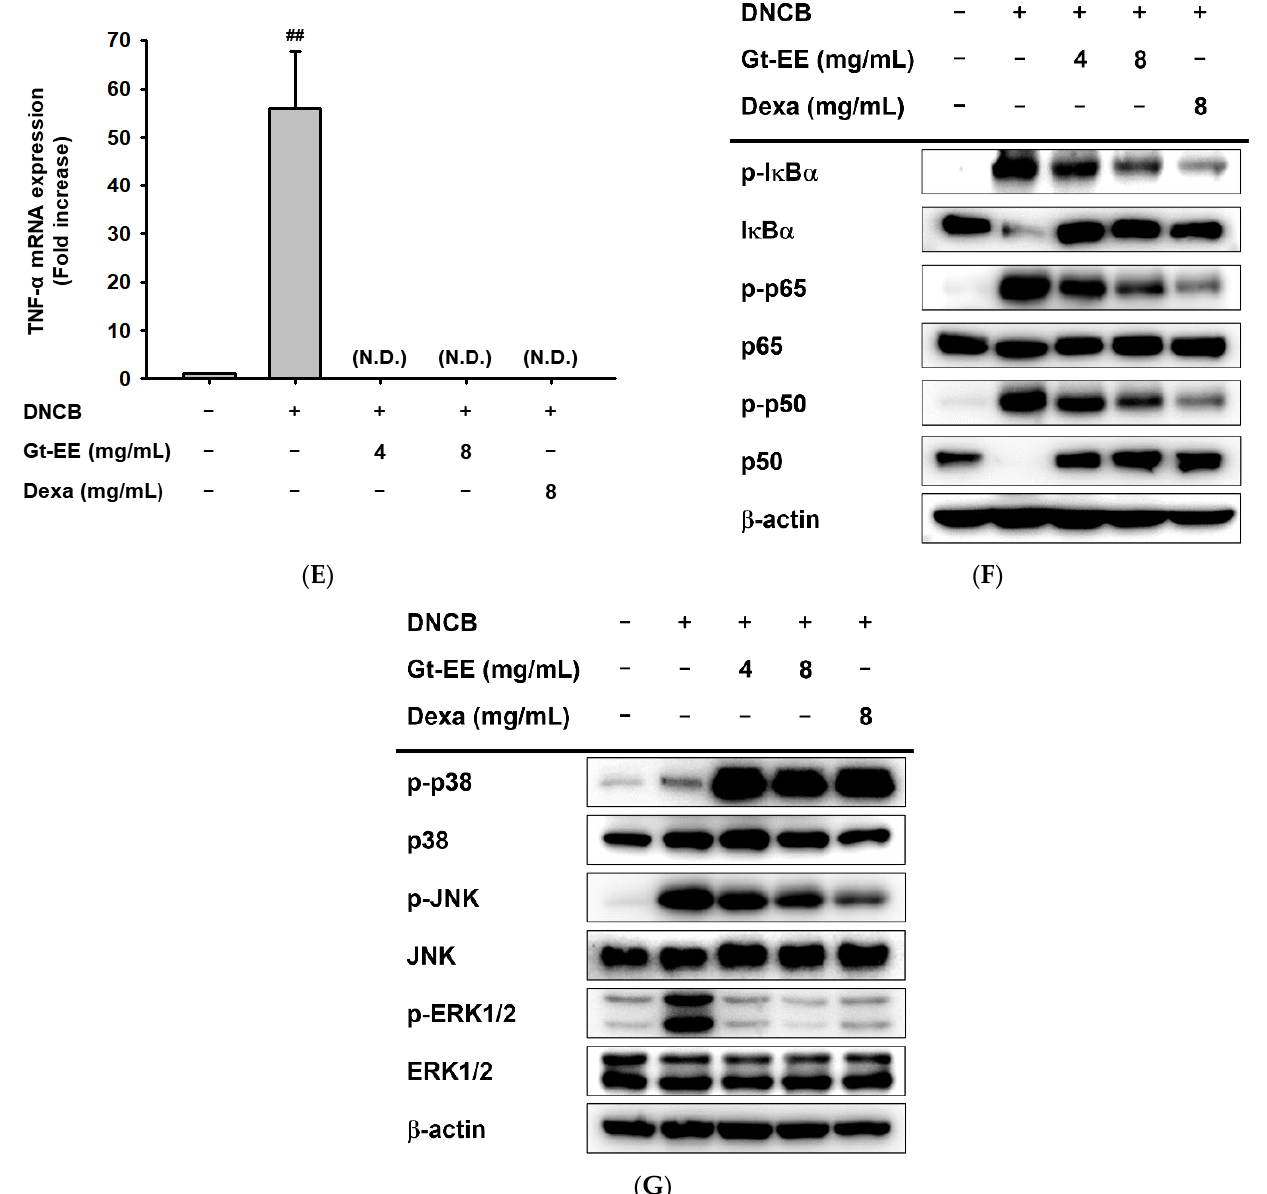
Figure 5. Gt-EE inhibits the mRNA expression of cytokines and activation of signaling pathways in DNCB-induced AD. ( A –E) The mRNA expression levels of IL-1 β , IL-4, IL-5, IL-6, and TNF- α were evaluated using real-time PCR. After euthanasia, the ears in which AD had been induced were dissected and ground, and total RNA was extracted for real-time PCR. ( F , G ) The total or phosphorylated forms of I κ B α , NF- κ B p65, p38, JNK, and ERK1/2 were measured using immunoblotting analysis. The total proteins were isolated from ears in which AD had been induced. ( A – E ) The results are expressed as mean ± standard deviation. Fold increase in 5A, 5D, and 5E was relative value compared with normal group, while fold increase in 5B and 5C was relative value compared with DNCB-treated group (Control group). N.D.: Not detected. ## p < 0.01, ### p < 0.001 compared with the normal group, and * p < 0.05, ** p < 0.01, *** p < 0.001 compared with the control group.